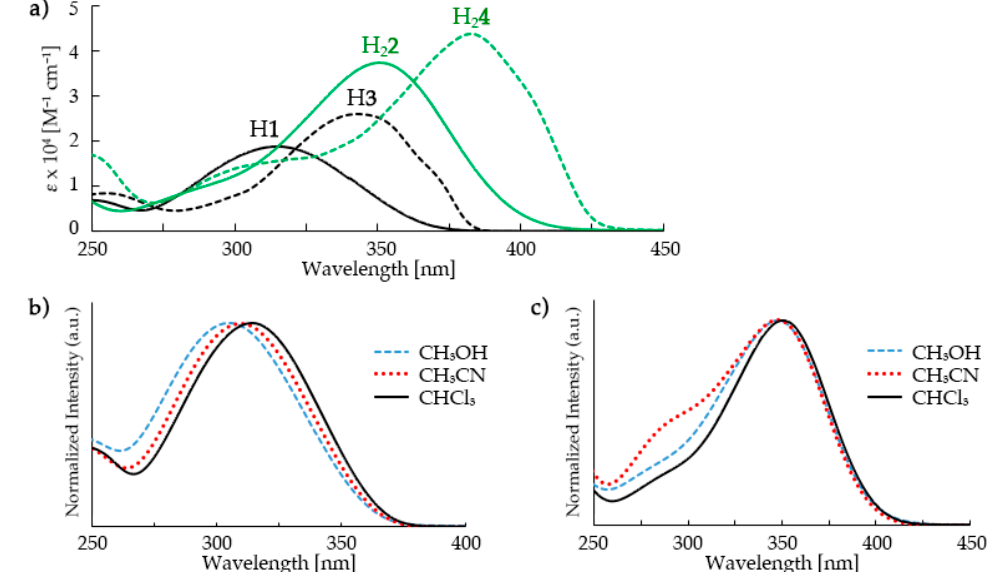
Figure 2. UV-Vis absorption spectra of ( a ) H 1 ~H 2 4 in CHCl 3 solution (40 µ M, 1 cm, rt.); and ( b ) H 1 and ( c ) H 2 2 in following solvents, CHCl 3 , CH 3 CN, and CH 3 OH (1.0 mM, 1 mm, rt).